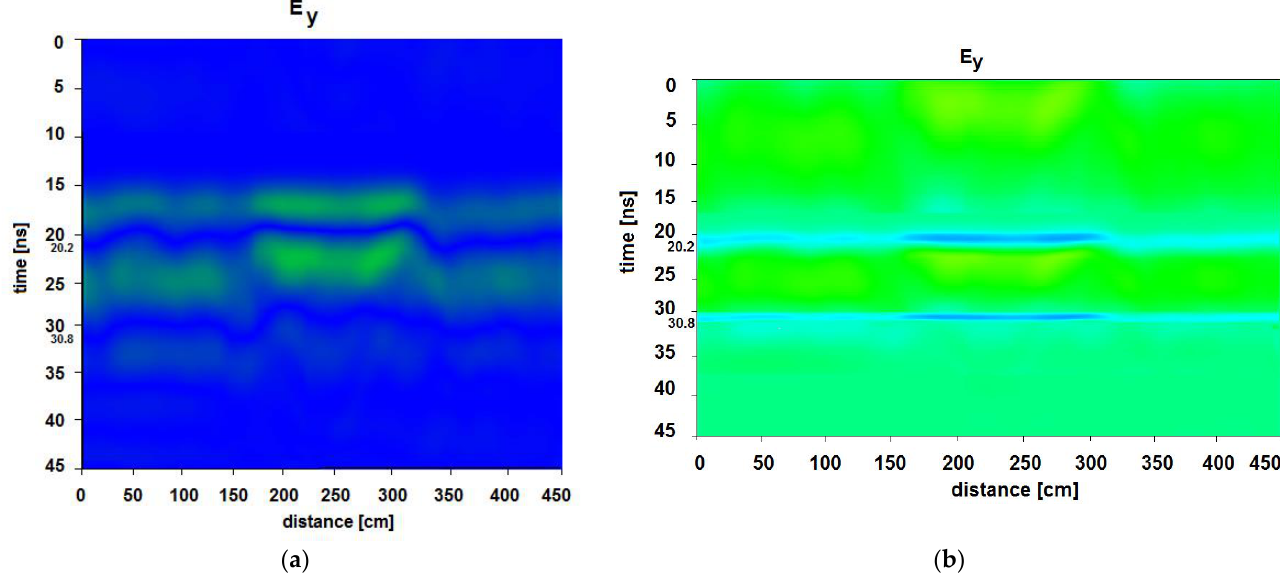
Figure 8. B-scan raw data processed after using both techniques: ( a ) ground removal; ( b ) migration.